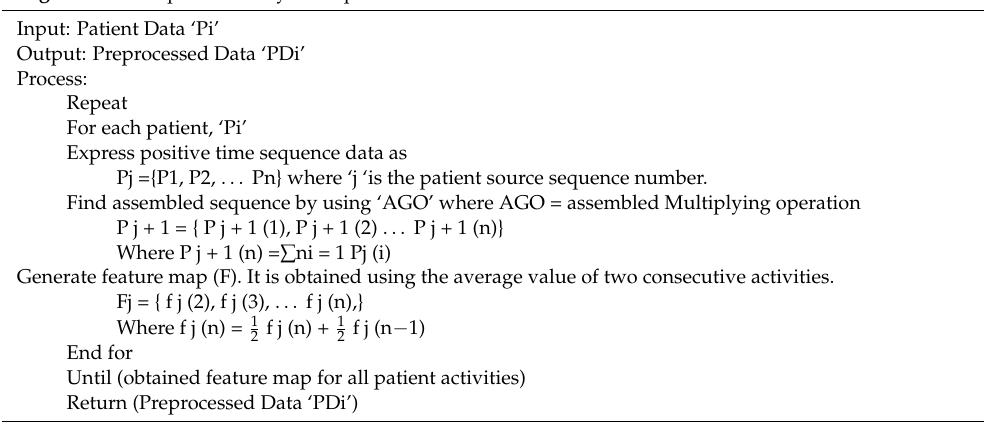
Algorithm 1: Preprocess: Grey Filter pseudo